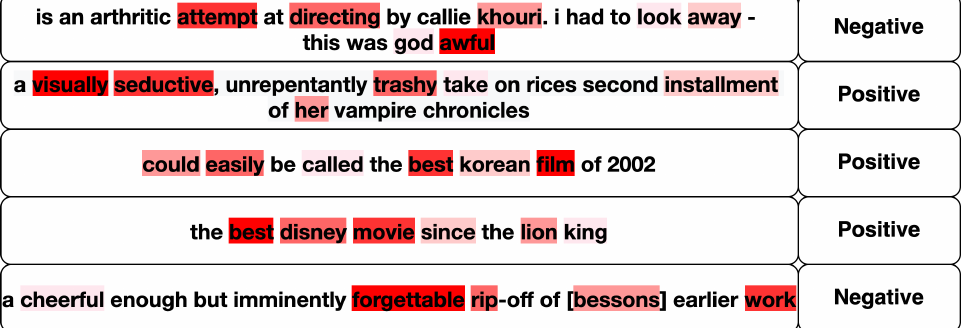
Figure 3. Visualization of attention weights with Bi-GRU only. Dark red to light red color represents the color gradients based on the attention weights in descending order.